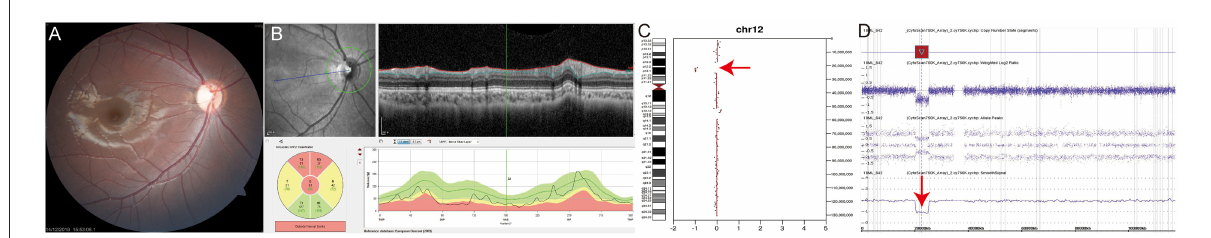
FIGURE2 (P12) Chromosomal copy number variations analysis using off-target reads reveals SOX5 deletion in Lamb–Shaffer syndrome. An 8-year-old female patient shows strabismus and hirsutism in the philtrum area. Best corrected visual acuity is 0.22 in the right eye and 0.40 in the left eye (logMAR). (A,B) Fundus photography and spectral-domain optical coherence tomography show optic nerve atrophy in both eyes (right eye was shown). (C) Deletion of the chromosome 12p12 is suspected by bioinformatics analysis using CopywriteR program (red arrow). (D) Array comparative genomic hybridization confirms 12p12.2p12.1 deletion (red arrow). Optic atrophy is thought to be related to SOX5 gene deletion. Regular cardiac function check-up is recommended because ABCC9 gene deletion is found by array comparative genomic hybridization.